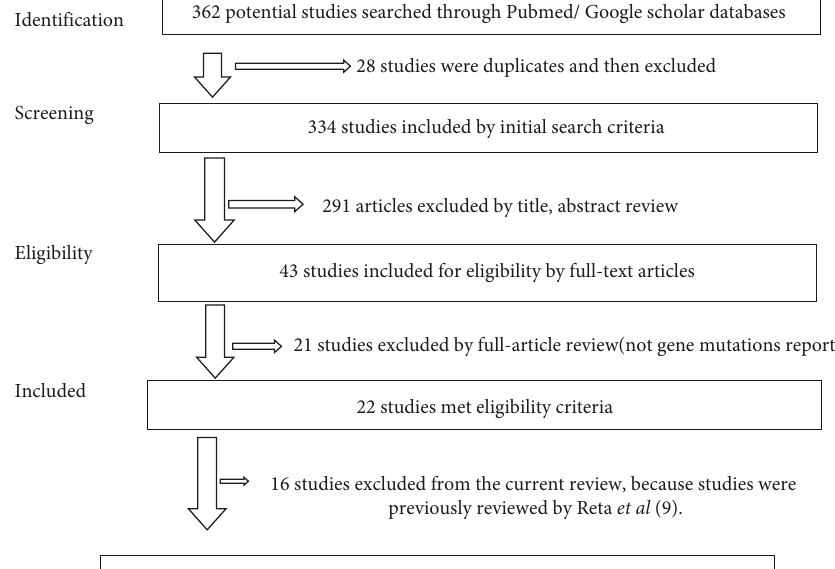
Figure 1: Flow diagram illustrating literature search